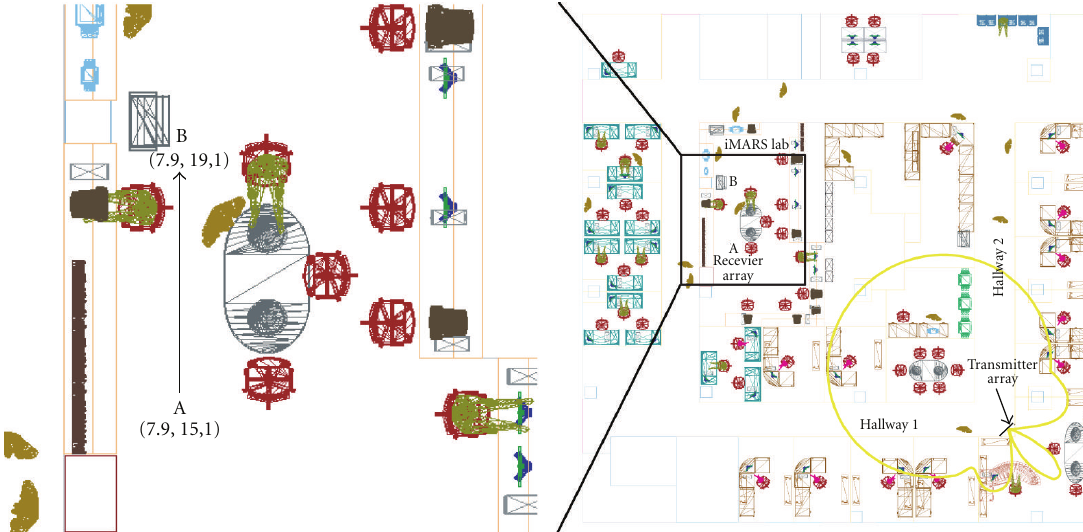
Figure 3: The simulated environment: A 2D top view of the third floor map of EIT building, University of Waterloo.